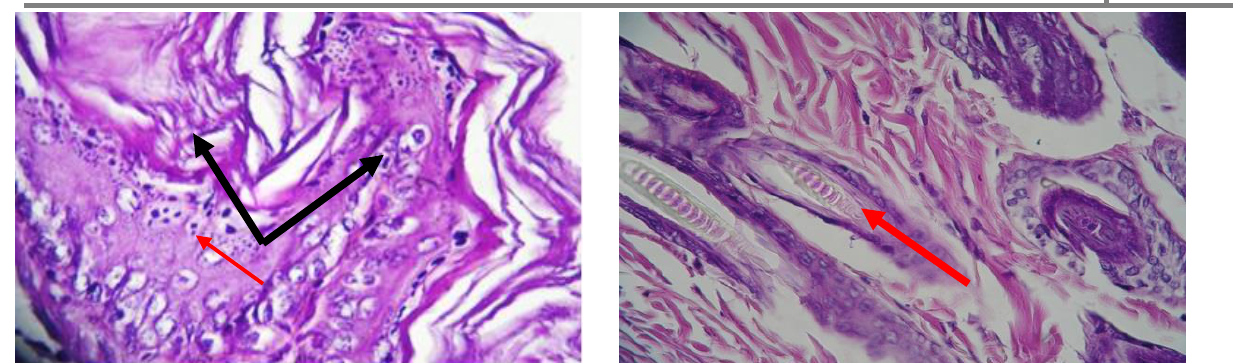
Figure,5: Section in the skin of infected non- immunized animal at day 14-post challenge showed epidermal hyperkeratosis and acanthosis In addition to present balloonic degeneration of some prickle cell accompanied with formation clumps of pyknotic nuclei (H&E stain 400X).